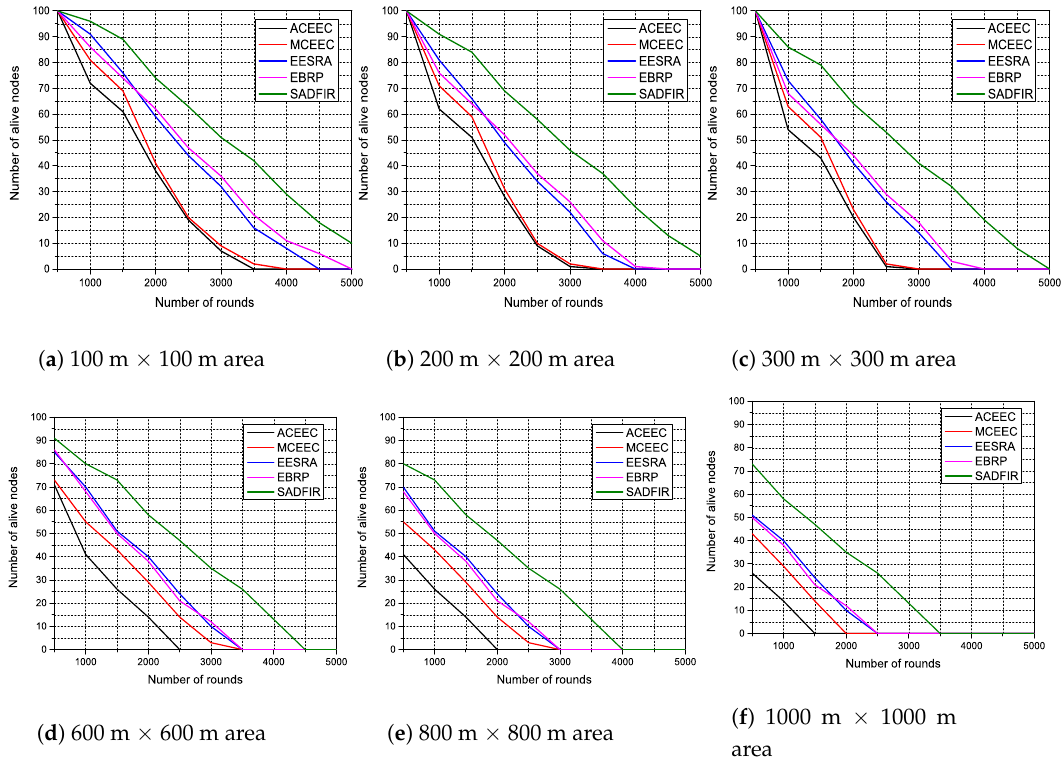
Figure 8. Energy Efficiency in terms of network lifetime in different scales of network